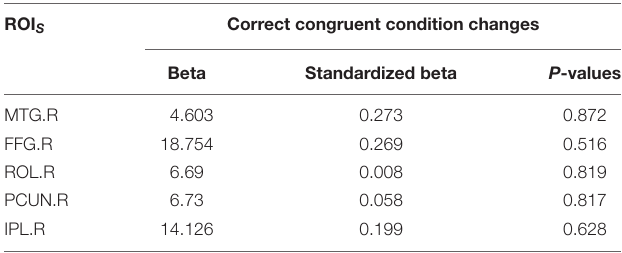
TABLE 4 | Regression analyses between functional connectivity changes and the correct congruent condition changes. ROI S Correct congruent condition changes Beta Standardized beta P -values MTG.R